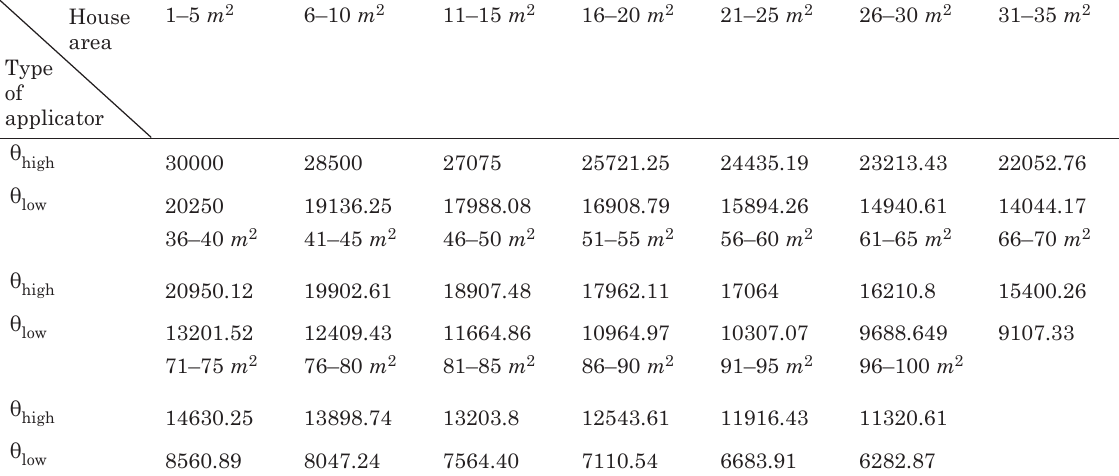
table 4. The marginal utility of different type of applicators for different house area